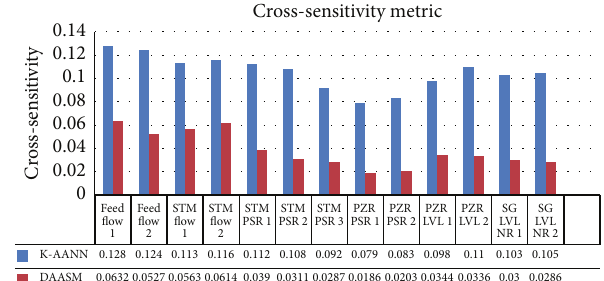
Figure 12: Cross-sensitivity values of individual sensors in both models.